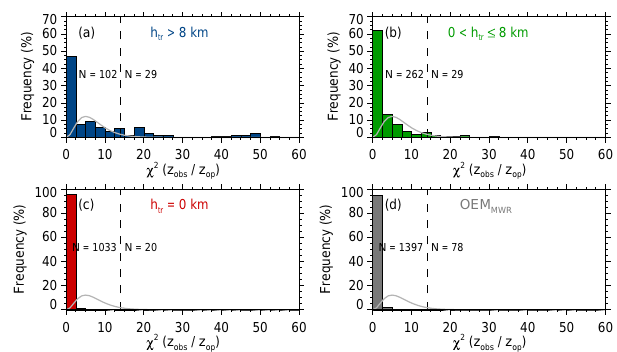
Figure 17. Histograms of the χ 2 test for the four situations given in Table 2. The dotted lines indicate the theoretical χ 2 distribution with m y degree of freedom. Dashed lines indicate the 5% threshold value of 14. The absolute number of cases below and above the threshold value is given to the left and to the right of the dashed line, respectively.